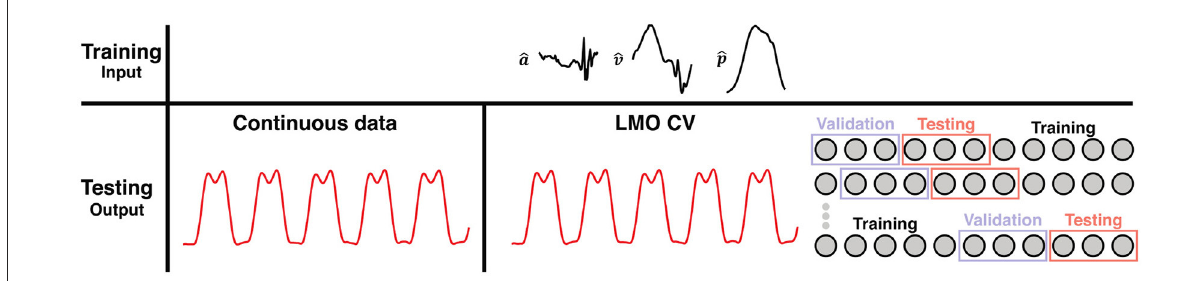
FIGURE3 Schematic of the different testing scenarios used for validating the robustness of the reservoir computer. A random trace of a walking trial is shown here. The input data ( ˆ a, ˆ v, ˆ p) were first segmented into strides (we considered 36 samples in time on either side of the foot off as transients when correcting for any learning errors in the beginning or end of the data). The first scenario, the training is performed on segmented data and the testing on continuous data. The continuous data (in red) represents the output of the reservoir, the vertical GRF waveforms. Secondly, the training was performed on segmented data, testing was done on continuous, but a leave-M-out cross-validation (LMO CV) was employed (split: 50/25/25% for training, validation, and testing, respectively). The vertical GRF in red represents the output of the trained reservoir during testing. LMO CV, Leave-M-out